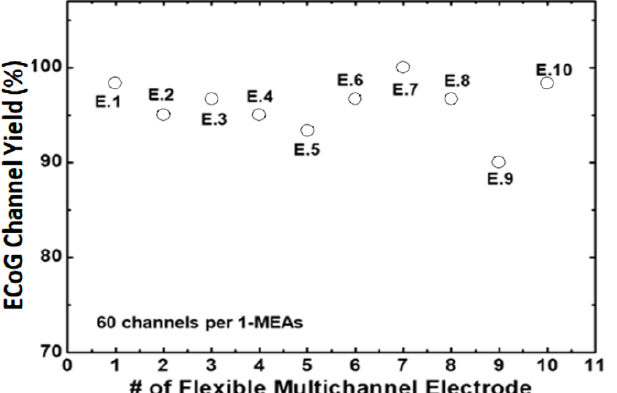
Figure 8. The electrocorticography (ECoG) channel yield measured from 60 channels per 1-MEAs. Table 1. Performance comparison of the proposed microelectrode arrays (MEAs) with several reported